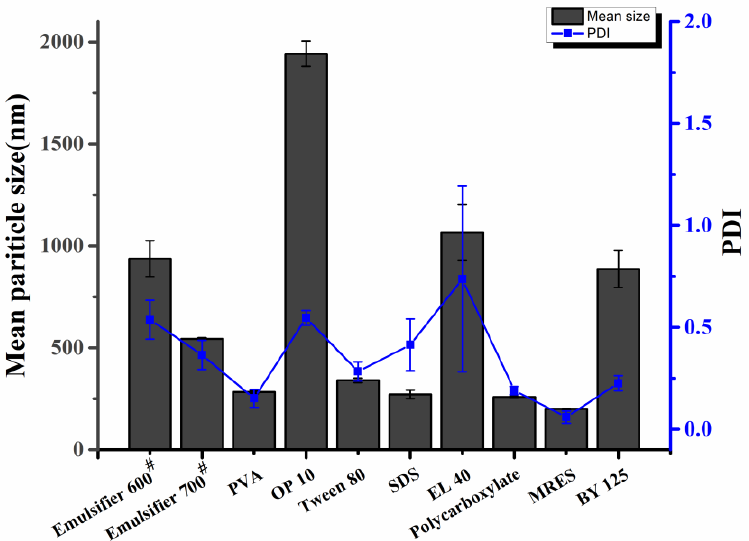
Figure 2. Effects of single surfactants on the mean particle size (MPS) and polydispersity index (PDI) of the nanocapsules.